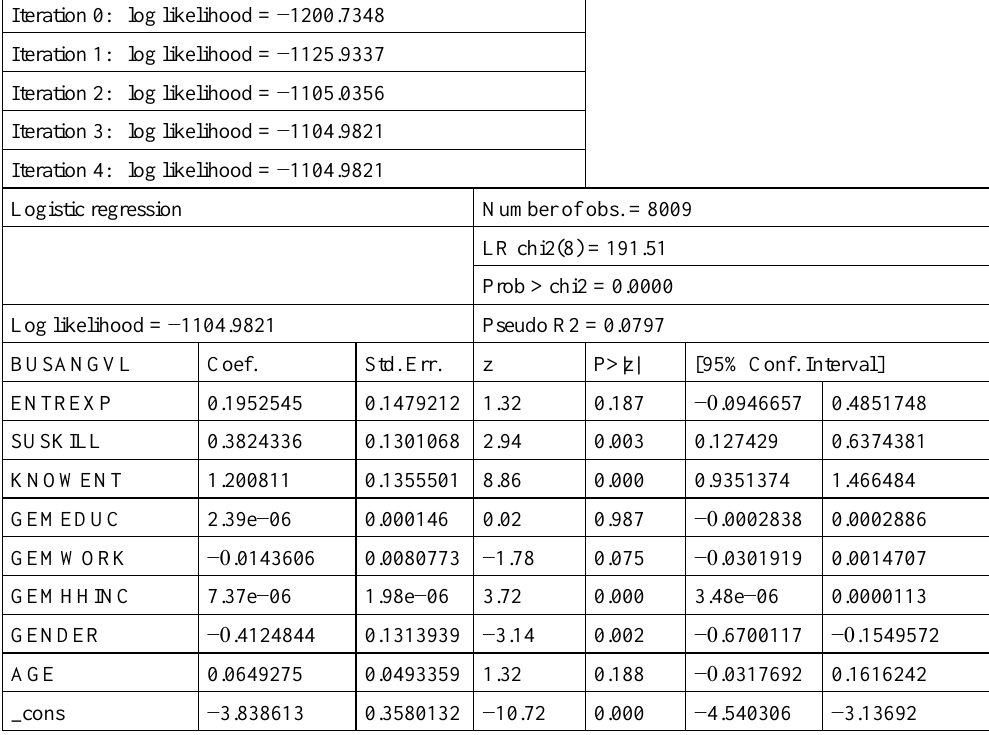
Table 5. The Logistic Regression Estimation of Informal Investment in the Efficiency-Driven Economies of Central